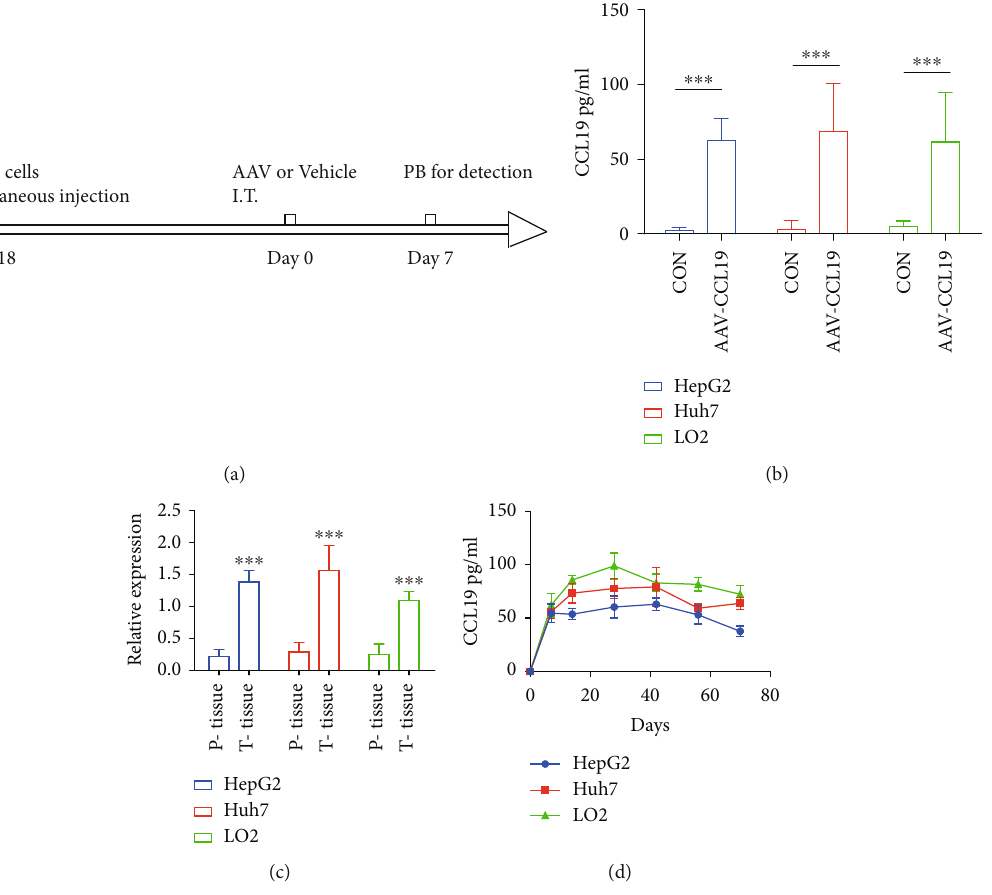
Figure 3: AAV-CCL19-mediated CCL19 expression in vivo. (a) Schematic diagram of in vivo experimental schedule; (b) detection of the CCL19 expression level in peripheral blood 7 days after intratumoral injection of AAV-CCL19; (c) analysis of CCL19 transcript levels in tumor and paraneoplastic tissues by qPCR; (d) long-term detection of CCL19 expression levels in peripheral blood. Error bars represent mean ± SD ( n = 5 ); ns: no signi fi cant di ff erence ∗∗∗ P < 0 : 001